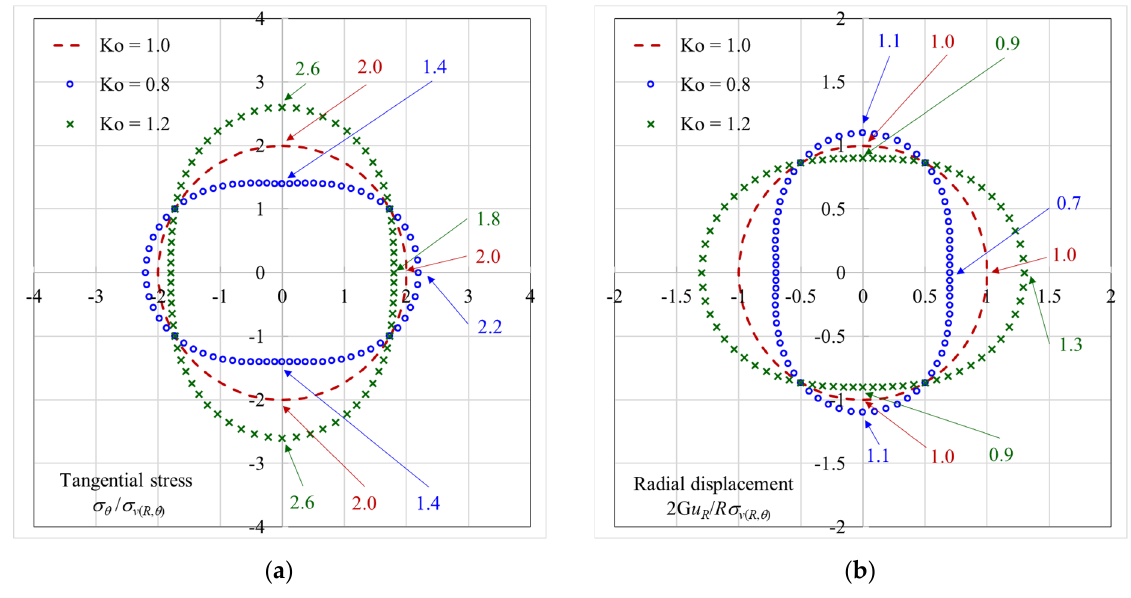
Figure 22. Ground reaction around the tunnel in the elastic media simulated by the EAM with λ = 1.0, and the distribution of ( a ) tangential stress and ( b ) radial displacement.